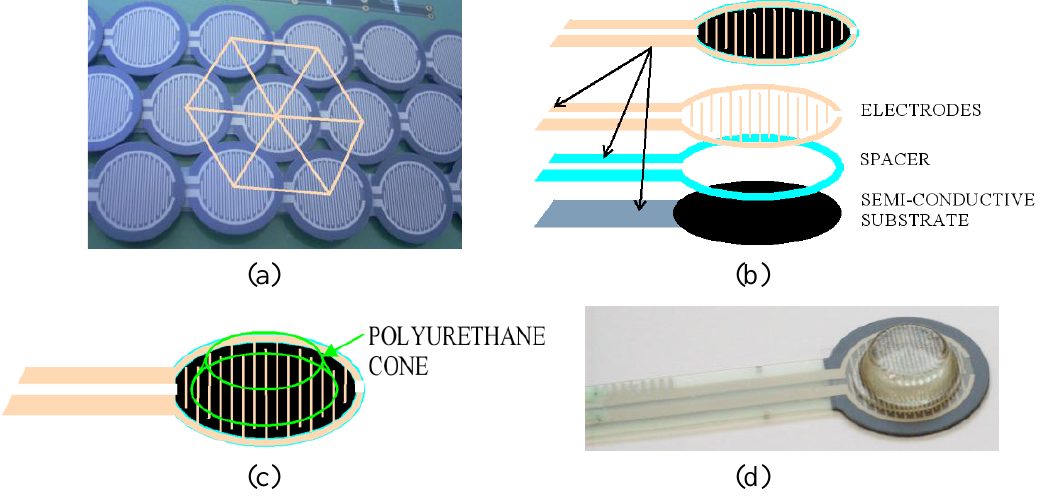
Figure 1. ( a ) Detail of the grid. ( b ) Layers in a Force Sensing Resistors from Interlink. ( c ) Draw of the sensor with a polyurethane cone atop. ( d ) A